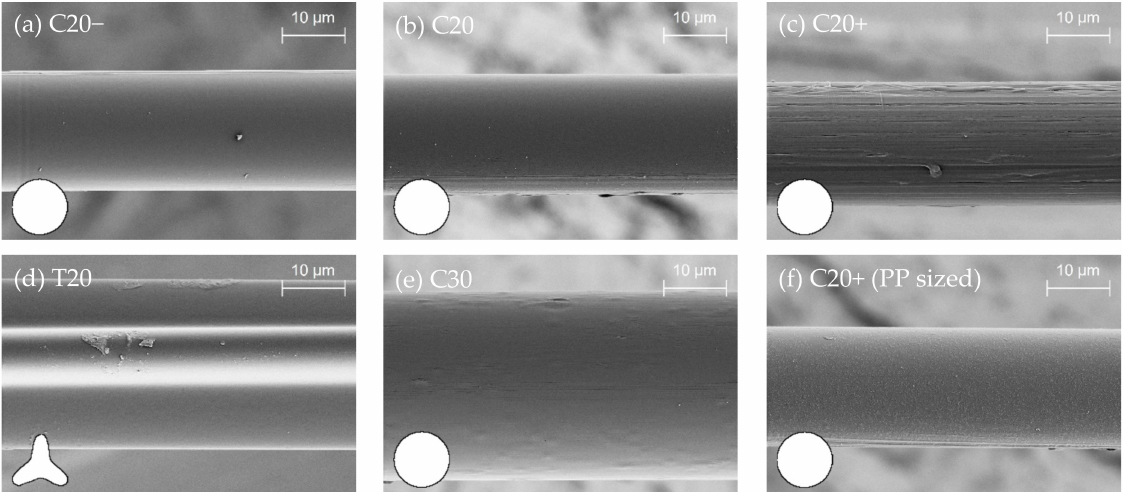
Figure 4. SEM images of spun circular fibers with a diameter of 20 µ m showing PP fibers with ( a ) low, ( b ) medium and ( c ) high mechanical properties; ( d ) trilobal fibers, ( e ) circular fibers with the increased diameter of 30 µ m and ( f ) PP- sized